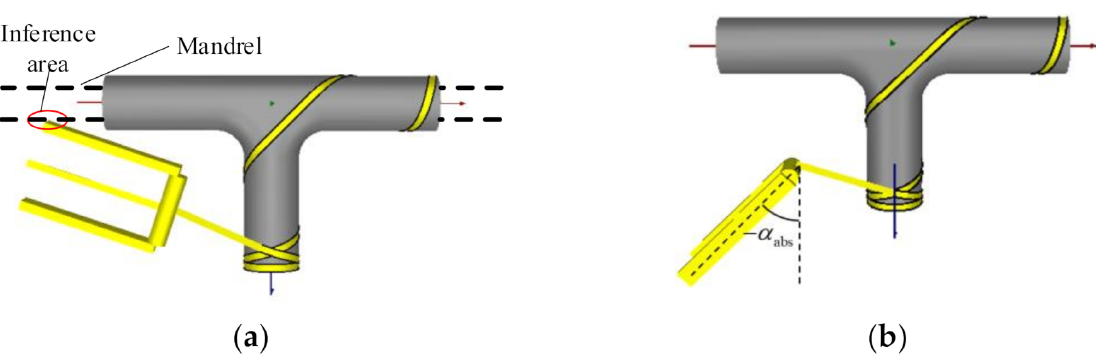
Figure 10. Interference in five coordinate system: ( a ) Interference caused by a large swing; ( b ) Restrained yaw coordinates. Like the four-axis solution, the five-axis solution also takes into account the influence of the roller diameter. The Fz axis is tangent to the surface of the yarn exit roller. Spindle rotation causes the yarn exit roller to the XZ plane of the fixed coordinate O. The five coordinates are obtained by Equation